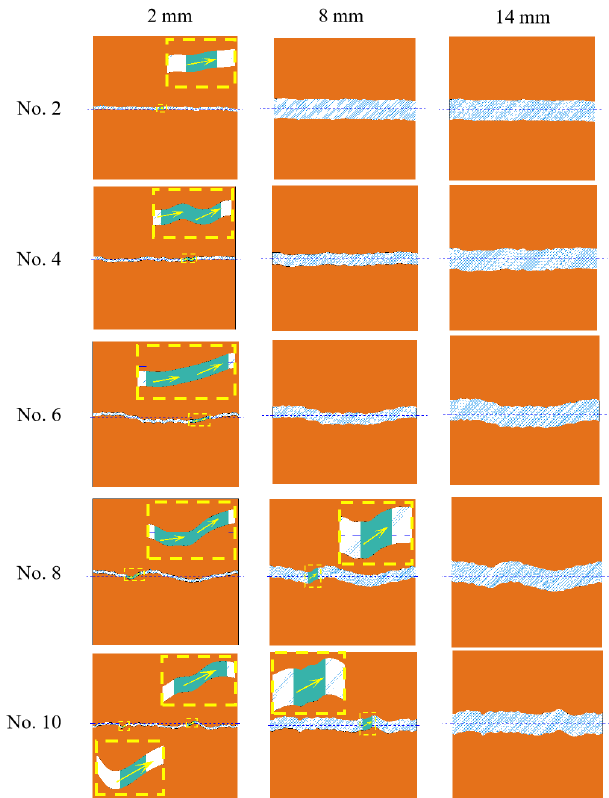
Figure 15. Influence of joint roughness on the shearing slip path. Experimental conditions: T =− 5 ◦ C, v = 0.2mmmin − 1 and σ n = 0.5MPa.